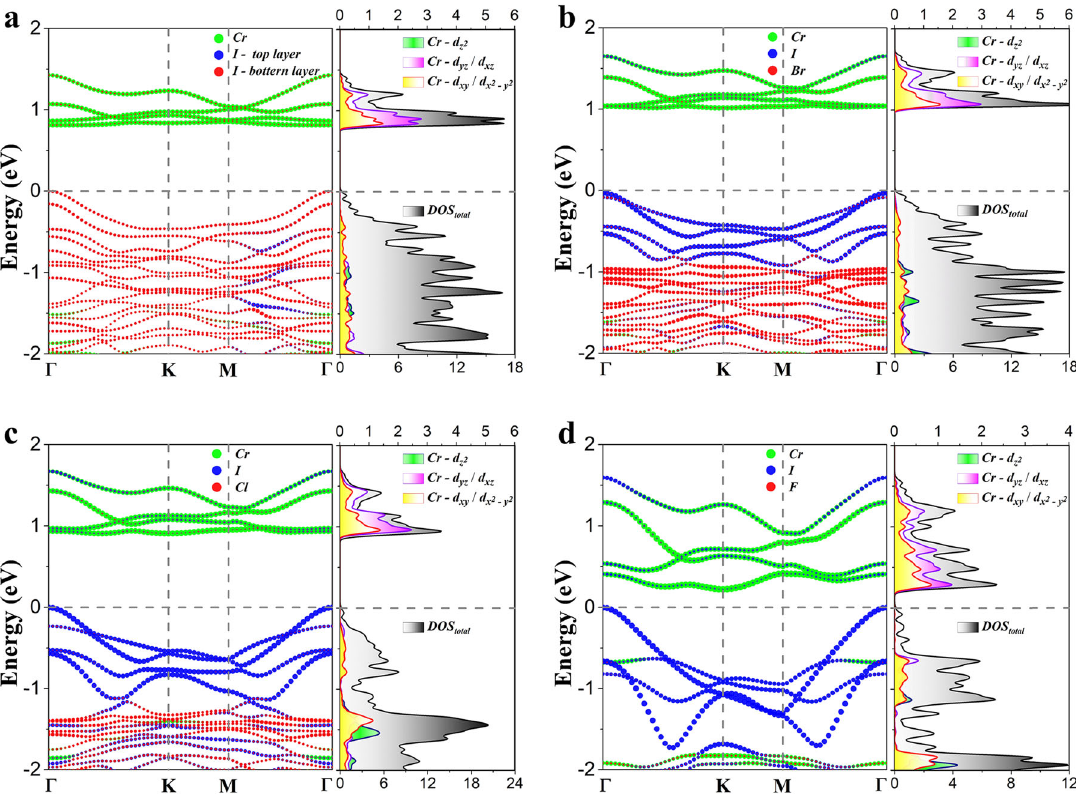
Fig. 2 Atom-resolved band structures of Janus monolayers and calculated DOSs. a – d Atom-resolved band structures of Janus monolayers and corresponding DOSs of ( a ) Cr 2 I 6 , ( b ) Cr 2 I 3 Br 3 , ( c ) Cr 2 I 3 Cl 3 , and ( d ) Cr 2 I 3 F 3 . The different proportions of occupancy Cr, I (or upper I), and Y (or lower I) atoms are represented by the green, blue, and red dots in the band scatter diagram, respectively. The black gradient fi lling in the right part of each diagram represents the total contribution of DOS, while the green, purple, and yellow gradient fi lling represent the projected contribution of d z 2 , d yz = d xz , d xy = d x 2 (cid:3) y 2 orbitals, respectively.